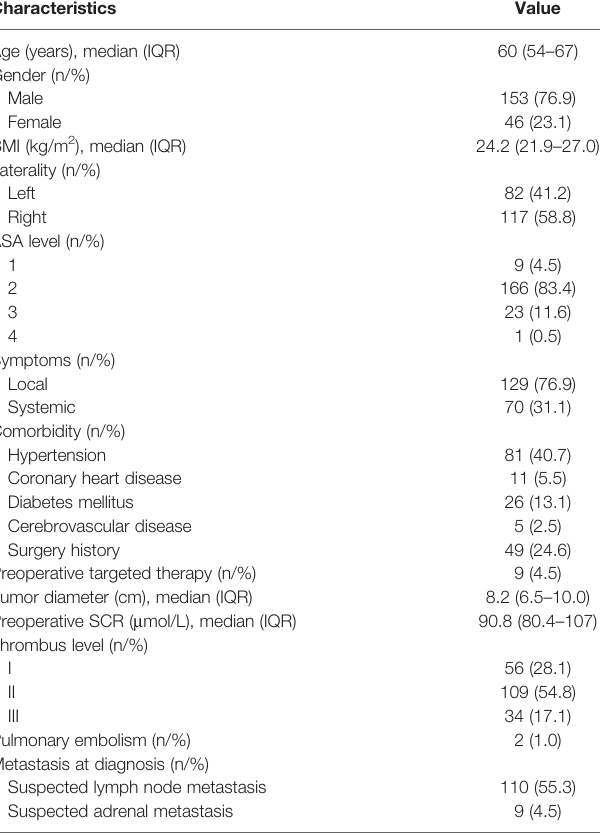
TABLE 1 | Baseline characteristics of the study cohort (n = 199).